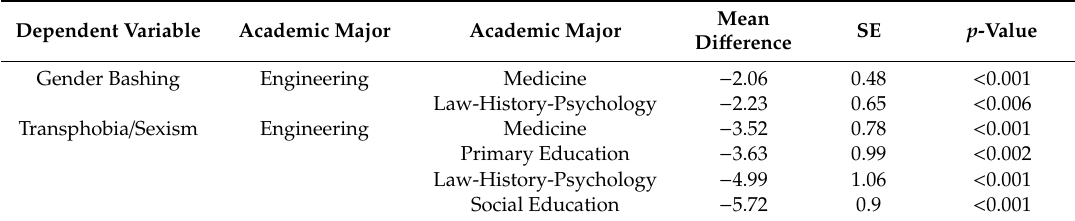
Table 3. MANOVA results comparing means on Gender Bashing and Transphobia / Sexism, according to academic